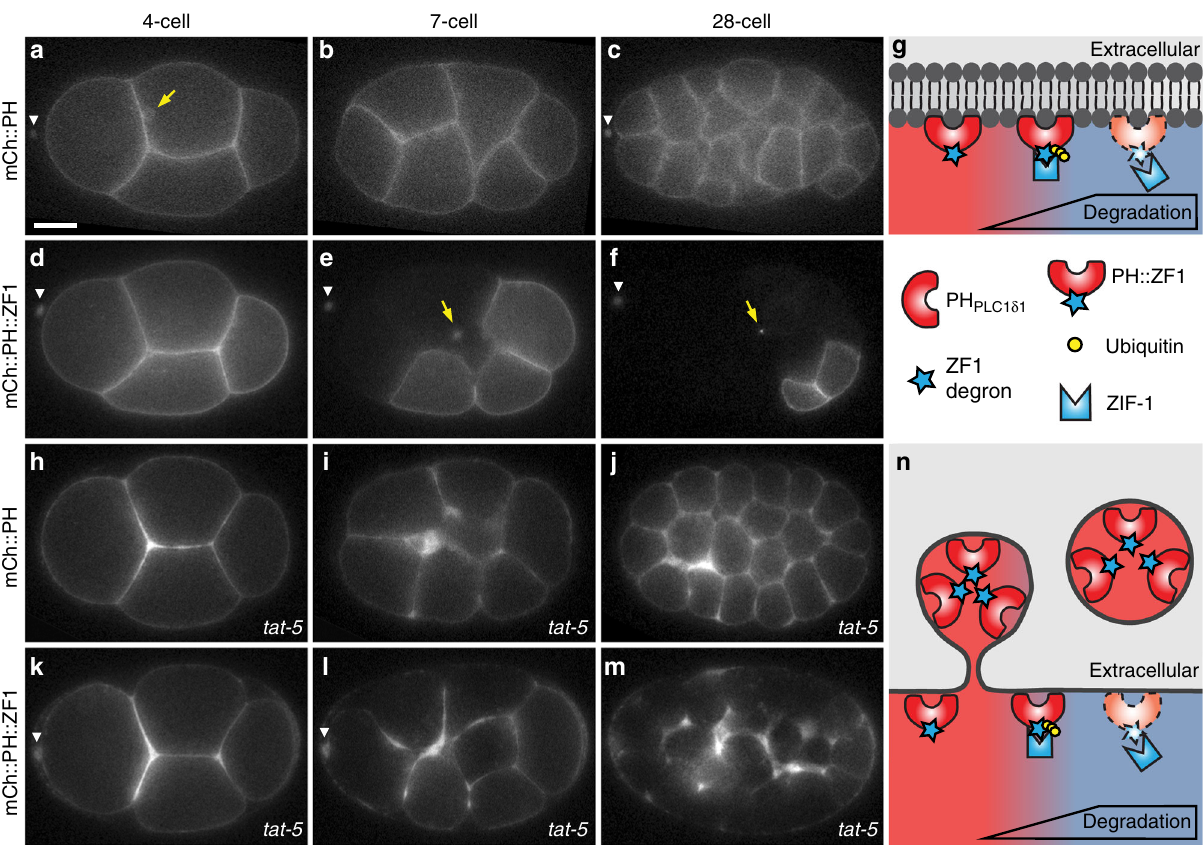
Fig. 2 The ZF1 degron enables labelling of speci fi c cells and vesicles in C. elegans embryos. a – c The PH domain of PLC1 ∂ 1 binds to lipids in the plasma membrane and an mCherry-tagged PH PLC1 ∂ 1 reporter (mCh::PH) localizes to the plasma membrane and endocytic vesicles (arrow) in 4-, 7-, and 28-cell embryos ( n = 19). Scale bar: 10 μ m. d – f ZIF-1-driven proteasomal degradation of the degron-tagged mCh::PH::ZF1 reporter starts in anterior blastomere (AB) cells during the four-cell stage ( d ), leading to the absence of the mCh::PH::ZF1 fl uorescence in anterior AB cells at the seven-cell stage ( e ) and most somatic cells at the 28-cell stage ( f , n = 10). The ubiquitin ligase adaptor ZIF-1 is not expressed in the posterior germ line or in anterior polar bodies (arrowhead), resulting in the persistence of mCh::PH::ZF1 in these cells. Arrows indicate labelled intracellular vesicles, which are protected from proteasomal degradation by intervening membranes. See also Supplementary Movie 1. Anterior is left, dorsal is up. g The lipid-binding PH domain tagged with the ZF1 degron is recognized by the ubiquitin ligase adaptor ZIF-1 and ubiquitinated. Polyubiquitination leads to proteasomal degradation of degron- tagged fl uorescent reporters (dotted lines). h – j Embryos treated with tat-5 RNAi show increased mCh::PH membrane labelling due to accumulated microvesicles at the 4-, 7-, and 28-cell stage ( n = 11). k Increased mCh::PH::ZF1 is visible at the four-cell stage in embryos treated with tat-5 RNAi. l – m Gradual degradation of mCh::PH::ZF1 in somatic cells facilitates visualization of released microvesicles in a 7- and 28-cell embryo ( n = 22). Due to degradation of cytosolic mCh::PH::ZF1 reporters at the plasma membrane, even small amounts of released microvesicles are easily visible. See also Supplementary Movie 1 and Supplementary Fig. 2. n Degron-tagged PH domain reporters are released in extracellular vesicles that bud from the plasma membrane before ZIF-1 expression. ZIF-1 expression leads to the ubiquitination and proteasomal degradation of cytosolic ZF1-tagged reporters (dotted lines). ZF1-tagged membrane reporters in released vesicles are not ubiquitinated or degraded and maintain fl progressively degraded, starting with anterior somatic cells (Fig. 2e – g, Supplementary Movie 1). ZIF-1 is not expressed in the germ lineage, resulting in persistent fl uorescence in a couple of posterior cells (Fig. 2e, f). ZIF-1 expression also does not occur in two small cell corpses born at the anterior side of the embryo during meiosis 14,20 . These polar bodies maintain mCh::PH::ZF1 fl uorescence (arrowheads in Fig. 2). Thus, the degron tag led to rapid degradation of a highly expressed, exogenous reporter in could therefore be ubiquitinated.